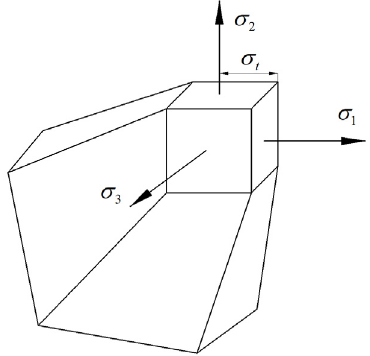
Figure 16. Mohr–Coulomb with tension cut-off yield surface.